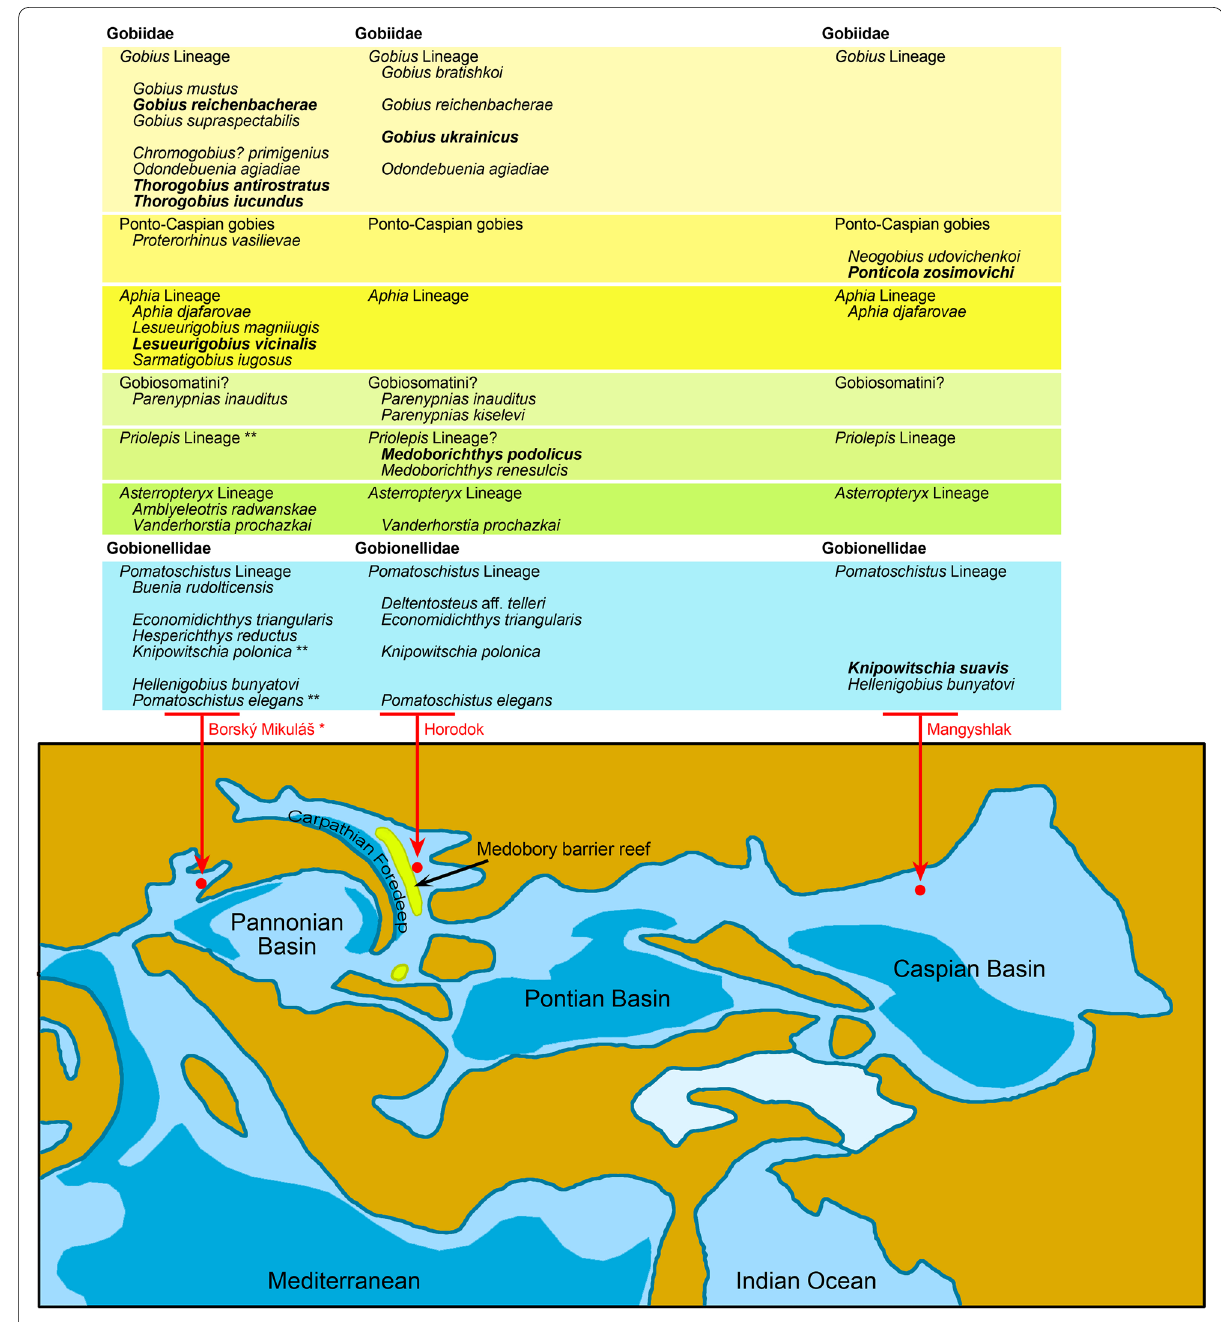
Fig. 12 Late Badenian paleogeography of the Paratethys and distribution of gobioid otolith-based taxa through the basin. Most common species are shown in bold printing ( Gobius reichenbacherae tentatively includes records of Gobius aff. niger by Brzobohatý et al., 2022). Asterisk denotes multiple locations, of which Borský Mikuláš represents the richest and most recently described otolith assemblage (Brzobohatý et al., 2022). Double asterisk denotes species only known in the Vienna Basin from the early Badenian and shown for correlation purposes. Paleogeography based on Rögl (1999), Popov et. al. (2004), and Kováč et. al.